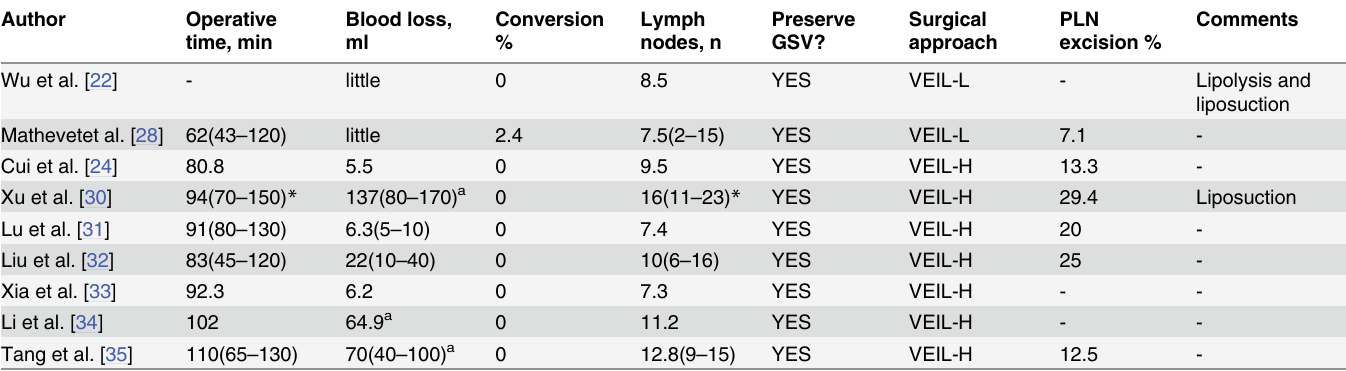
Table 2. Operative VEIL